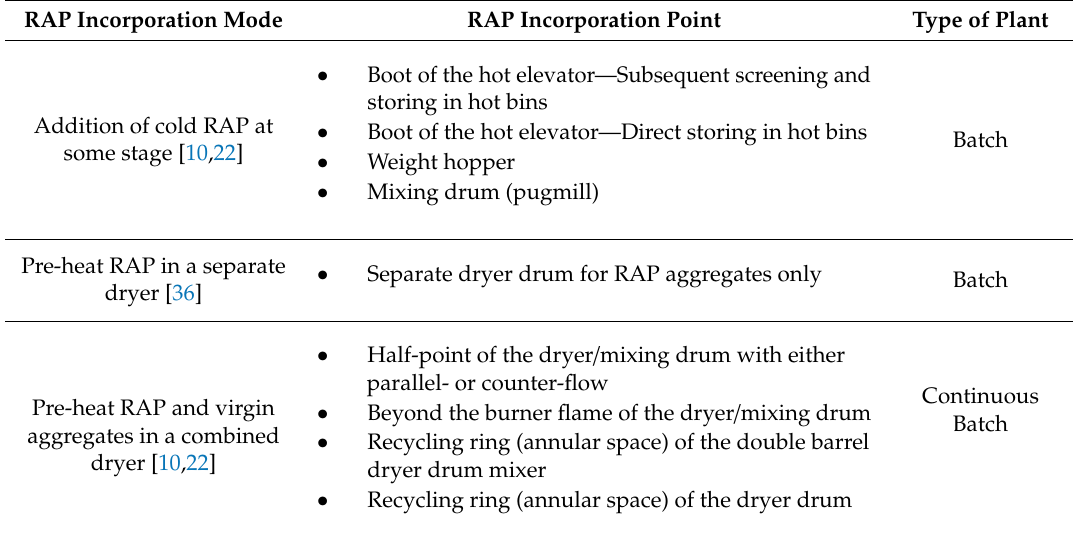
Table 3. Overview of the RAP incorporation modes and points in batch and continuous